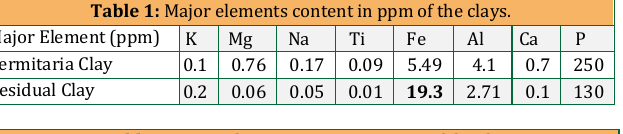
Figure 4: XRD pattern plot of Termitaria clay, showing the various minerals.